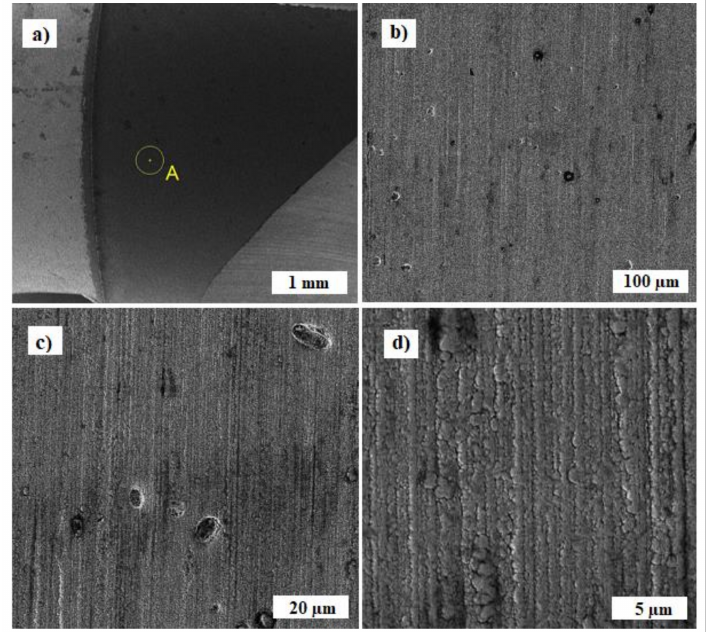
Figure 7. SEM secondary electron mode (SE) images of the place of examination, marked with the letter A ( a ), details ( b – d ) provide a detailed view of the morphology of the TiAlN coating.